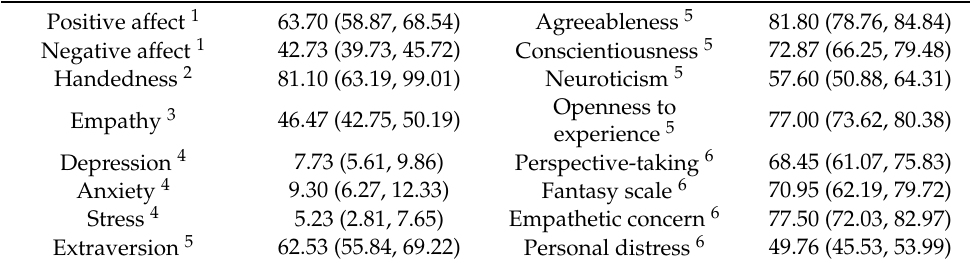
Table 2. Participants’ characteristics (mean percentages with 95% CI).